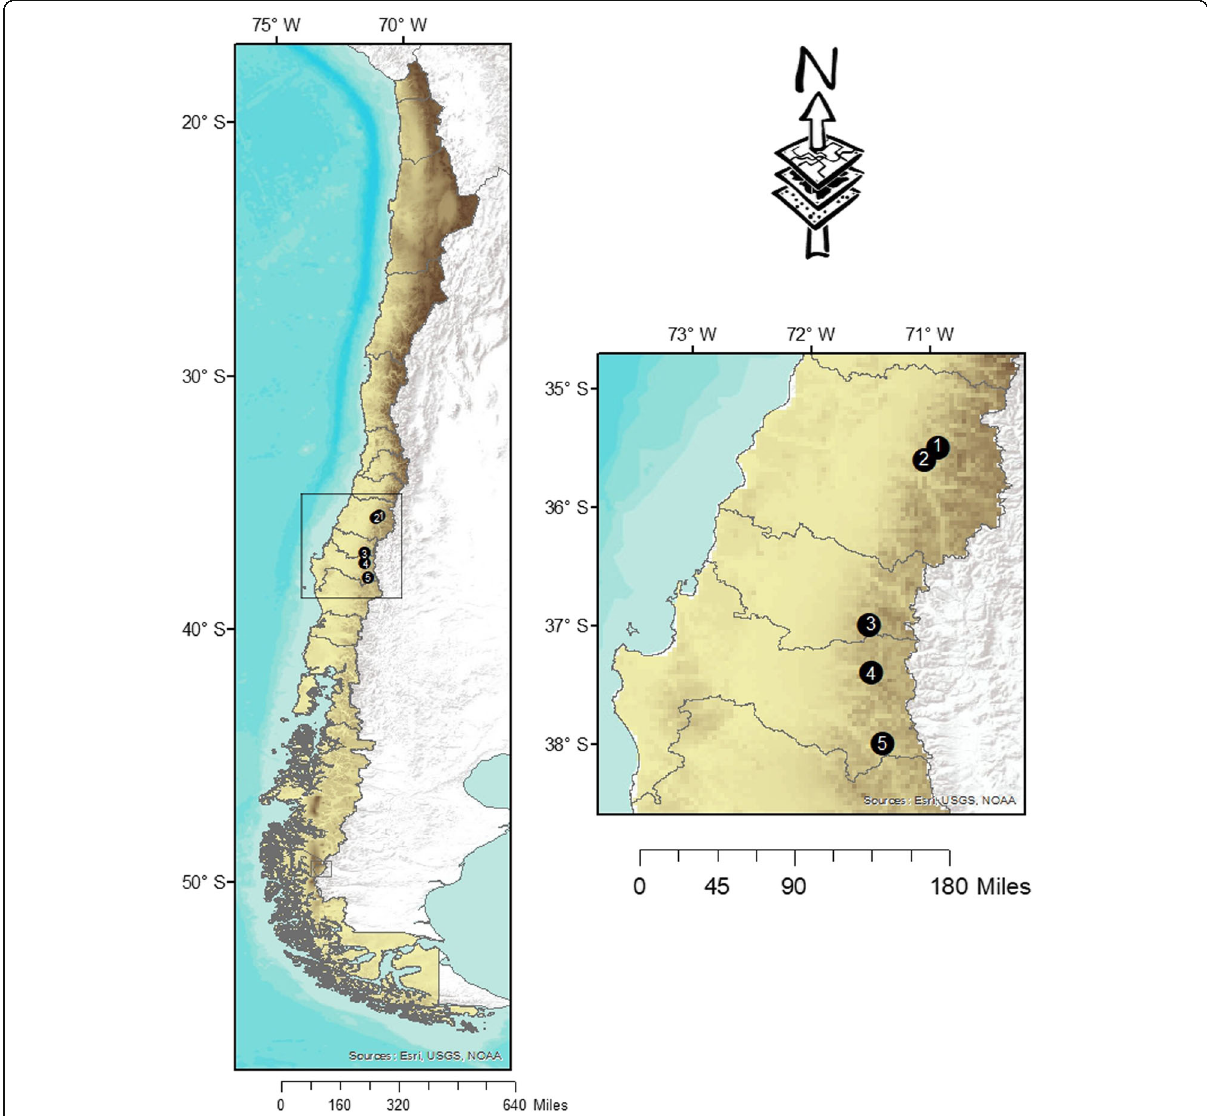
Fig. 1 Distribución geográfica de Telmatobufo venustus . (1) Parque Nacional Radal Siete Tazas (2) Altos de Vilches, (3) Cordillera de Chillán (lugar indeterminado), (4) Altos de Malalcura. (5) Ralco. Geographic distribution of Telmatobufo venustus . (1) Parque Nacional Radal Siete Tazas (2) Altos de Vilches, (3) Cordillera de Chillán (undetermined location), (4) Altos de Malalcura. (5)